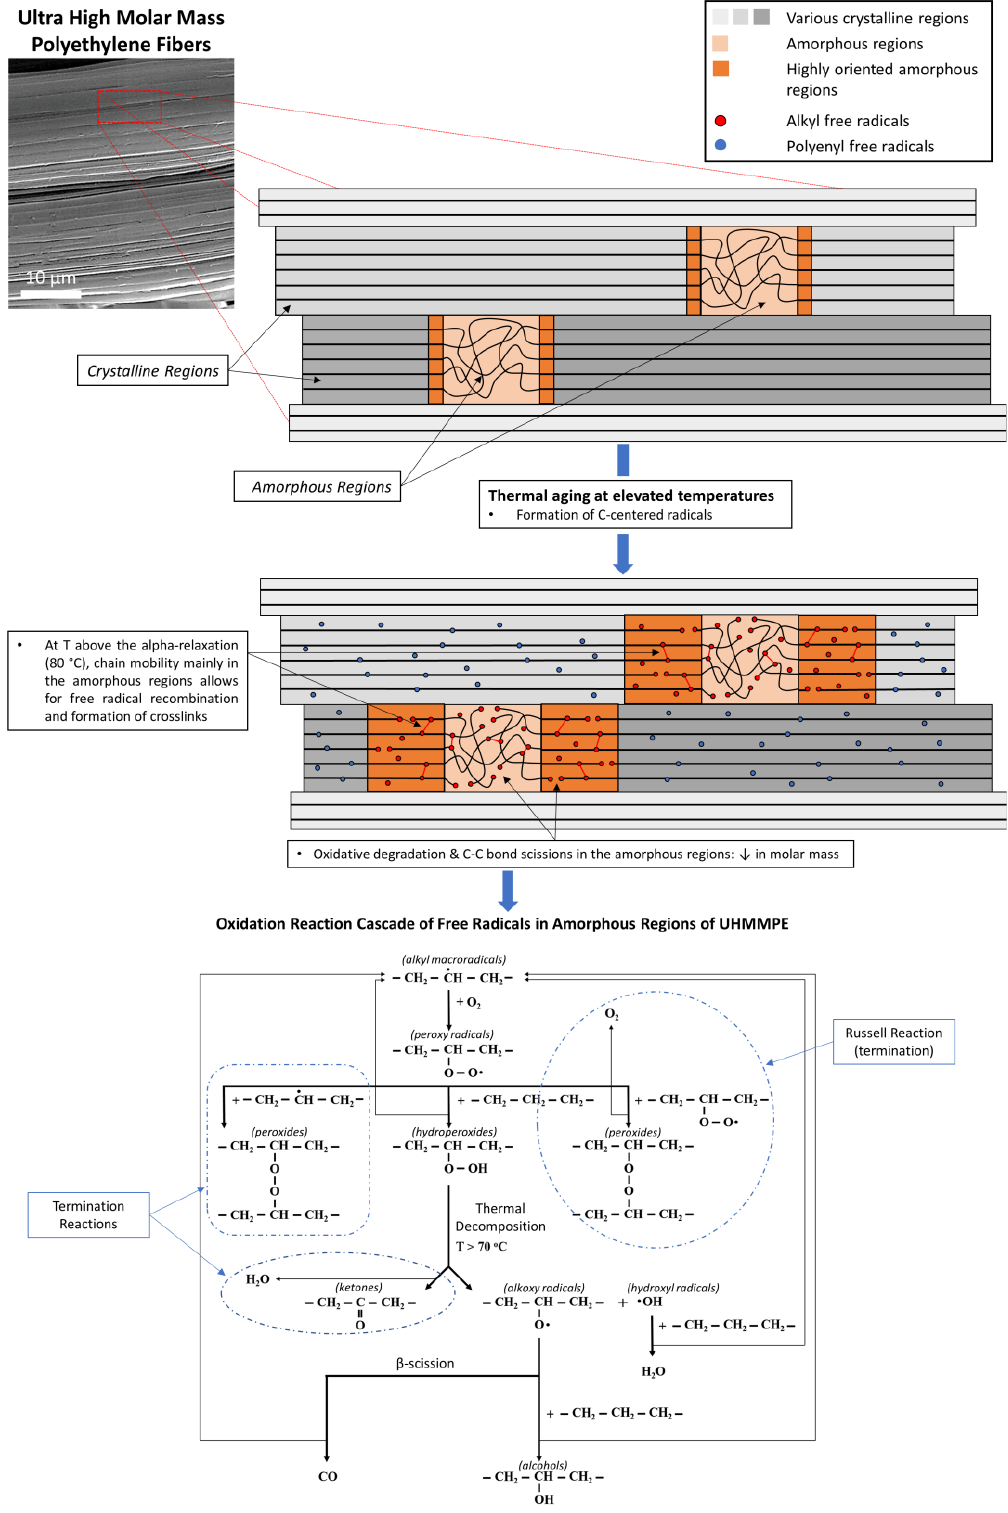
Figure 2. Thermal oxidation of UHMMPE fibers. Schematic of the crystalline and amorphous regions within the polymer fibers; formation of free radicals and the cascade of oxidation reaction in the amorphous